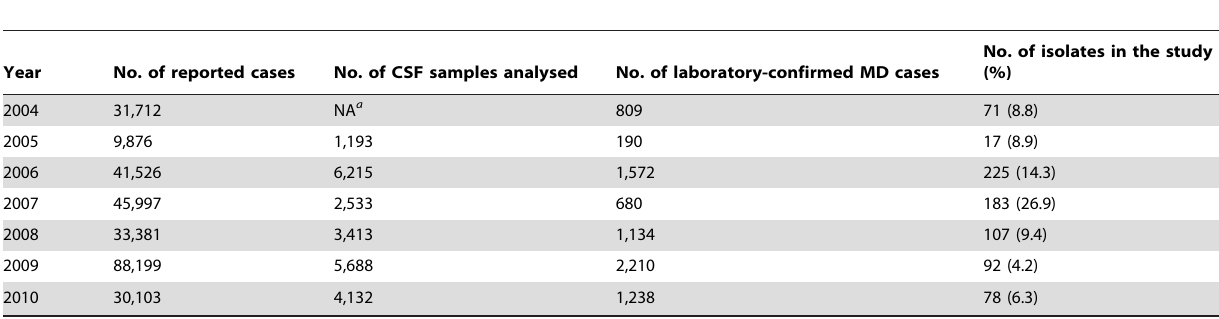
Table 4. Number (%) of studied isolates in relation to the number of laboratory-confirmed cases and number of reported cases per year in countries of the meningitis